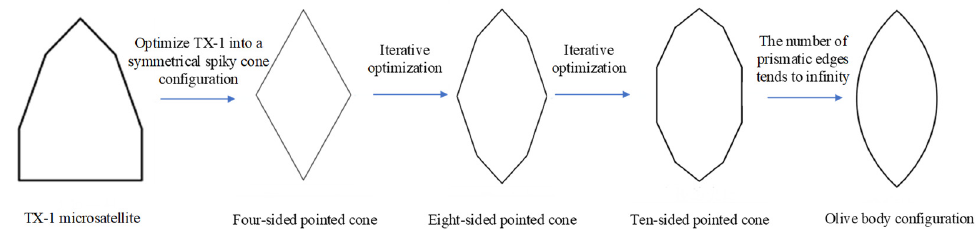
Figure 2. Stealthy configuration optimization design of the satellite.